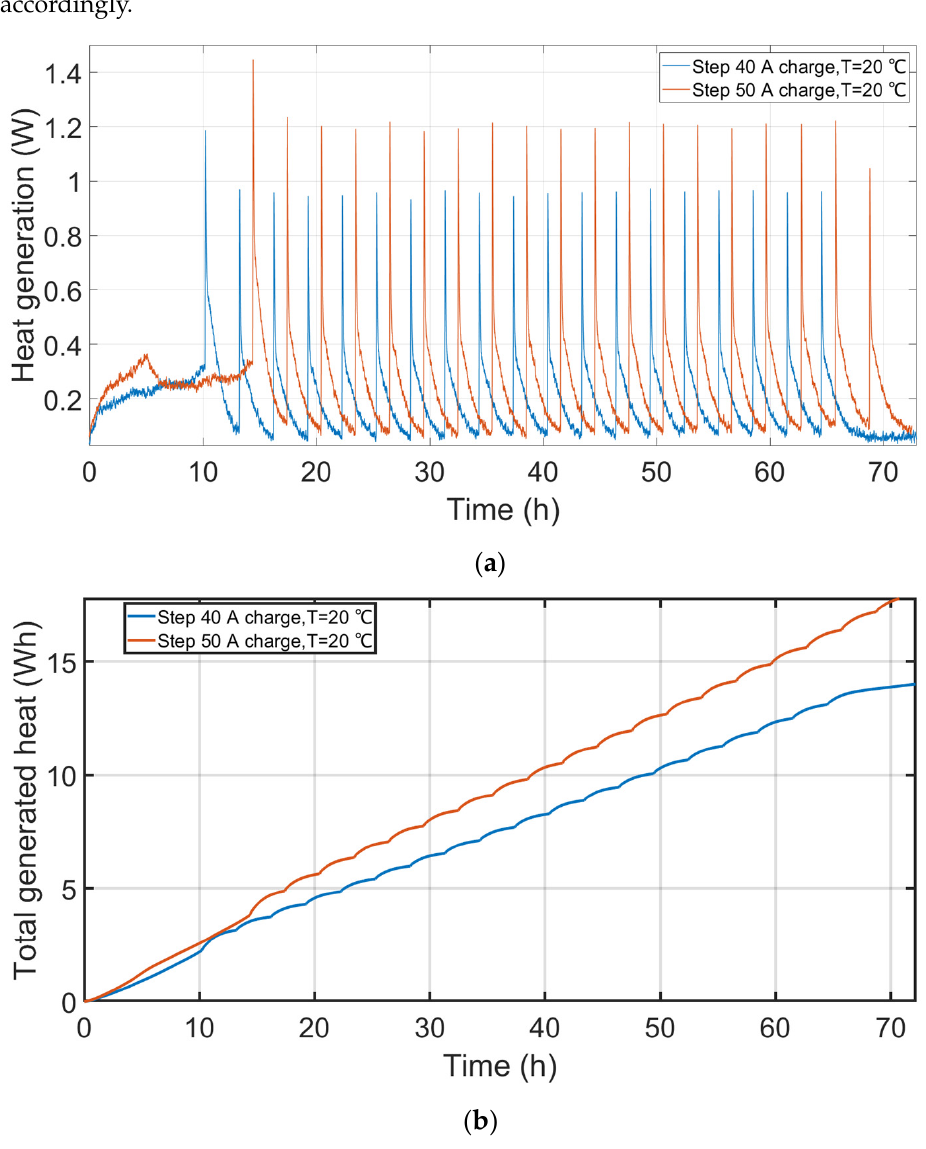
Figure 3. Thermal characterizations of a lithium titanate oxide-based lithium-ion battery, ( a ) heat generation evolution for case A, ( b ) Total generated heat for case A.